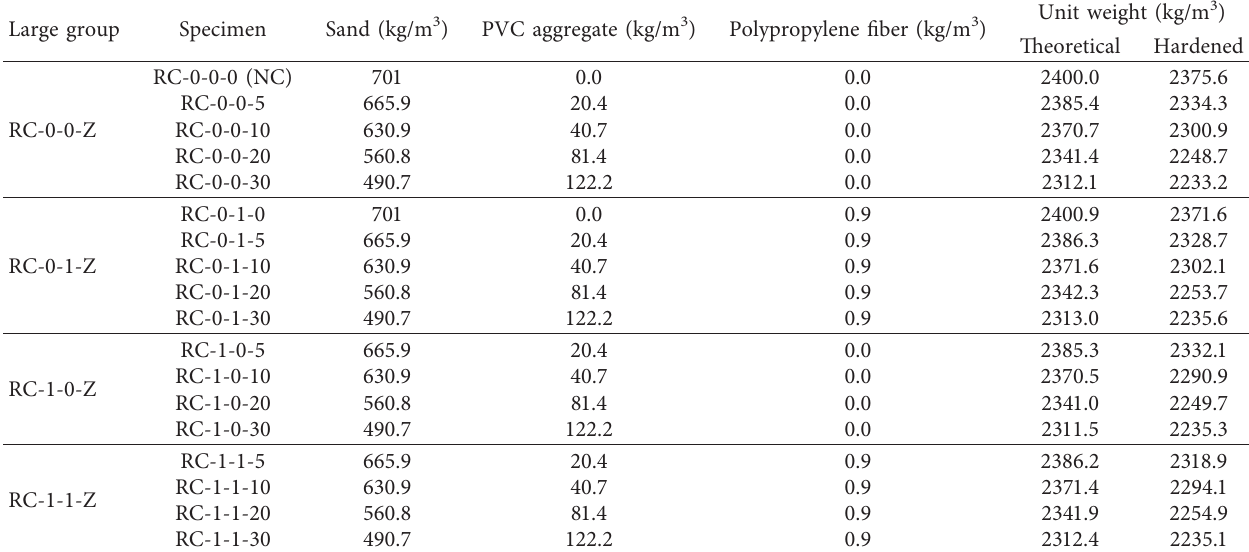
Table 2: Concrete mix proportions and unit